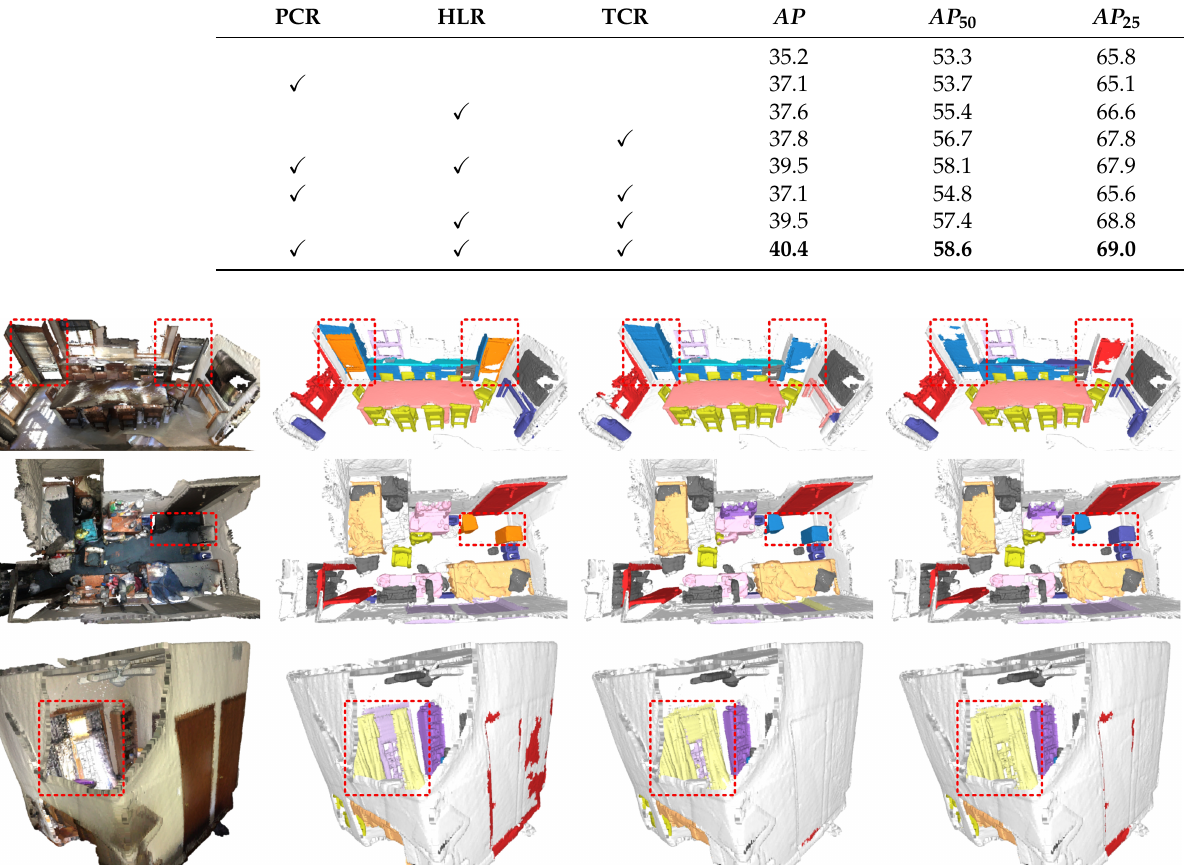
Table 3. Ablation study on ScanNet-v2. The highest performance in each column is marked in bold.